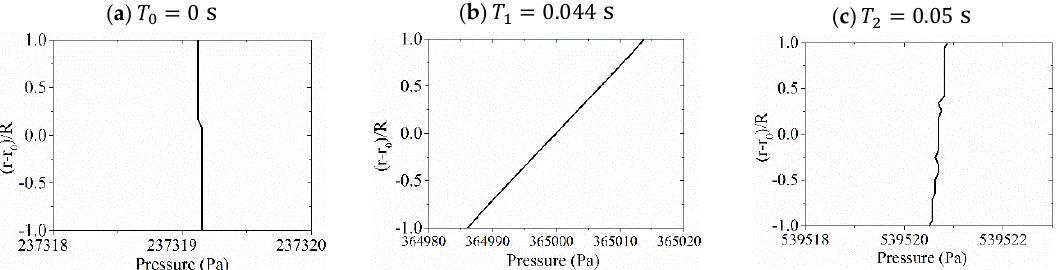
Figure 11. Local pressure distribution at S1 monitoring position of different time ( 𝑇 0 = 0 s , 𝑇 1 = 0.044 s , and 𝑇 2 = 0.05 s ).